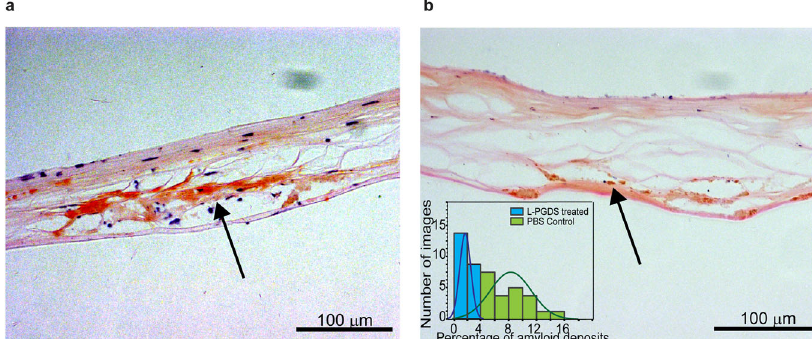
Fig. 5 Ex vivo disaggregation effects of L-PGDS on corneal samples. Corneal images collected from a patient with R124C mutation with Congo red staining incubated with ( a ) control PBS buffer and ( b ) the same buffer containing 10 μ M L-PGDS. The amyloid deposits are indicated by the black arrow. The histogram shows the distribution of the area of amyloid deposits in corneal samples treated PBS control and 10 μ M